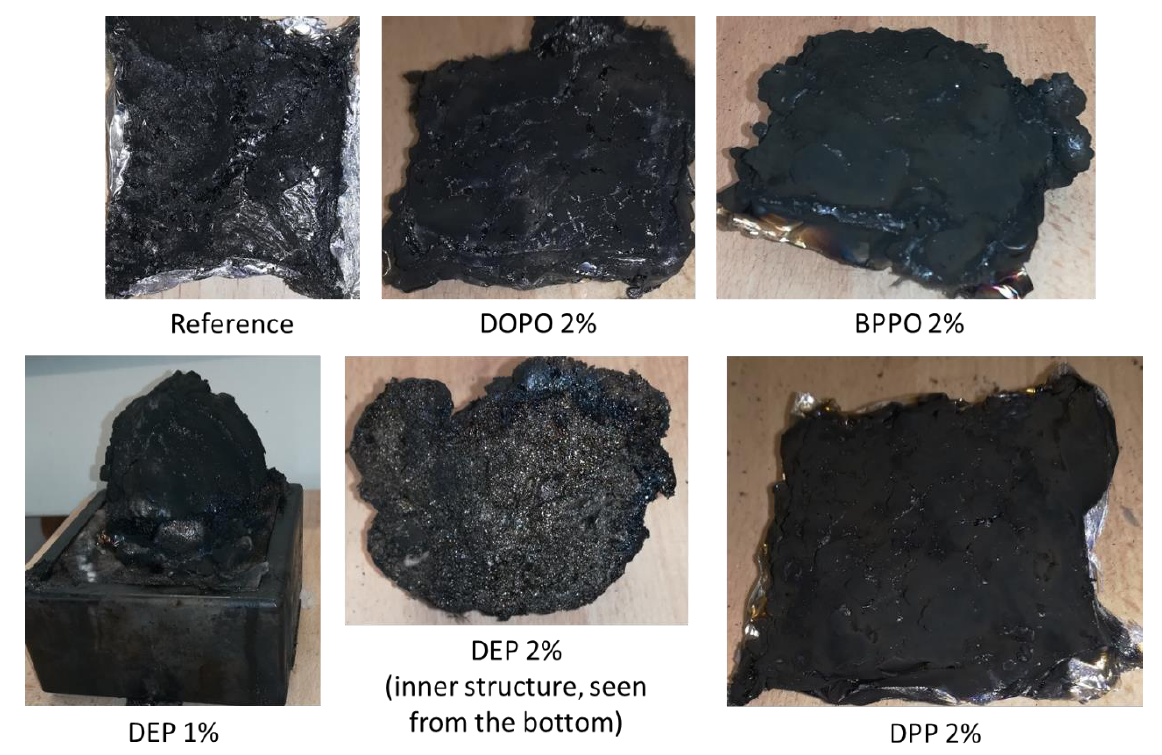
Figure 6. Pictures from some chars obtained after cone calorimeter tests.